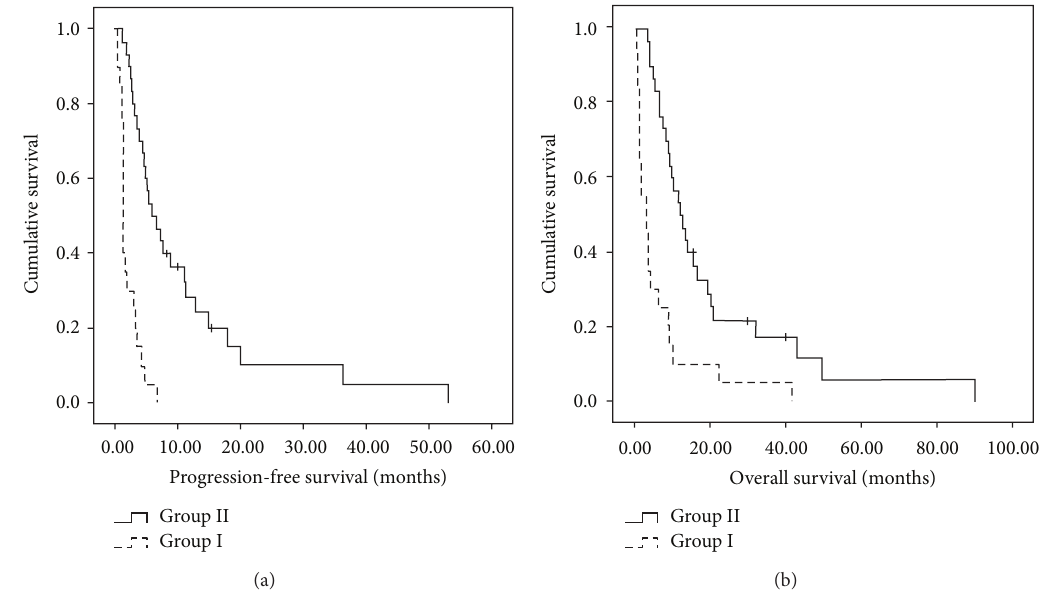
Figure 2: (a) Cumulative survival curve of progression-free survival. (b) Cumulative survival curve of overall survival.